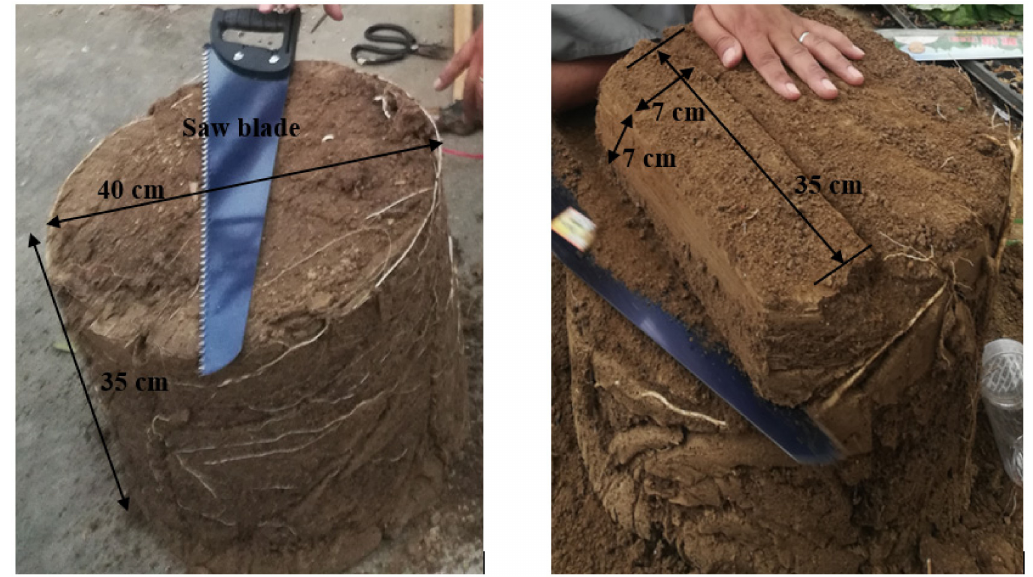
Figure 2. Soil ball and cutting soil ball into 7 × 7 × 7 cm 3 sample